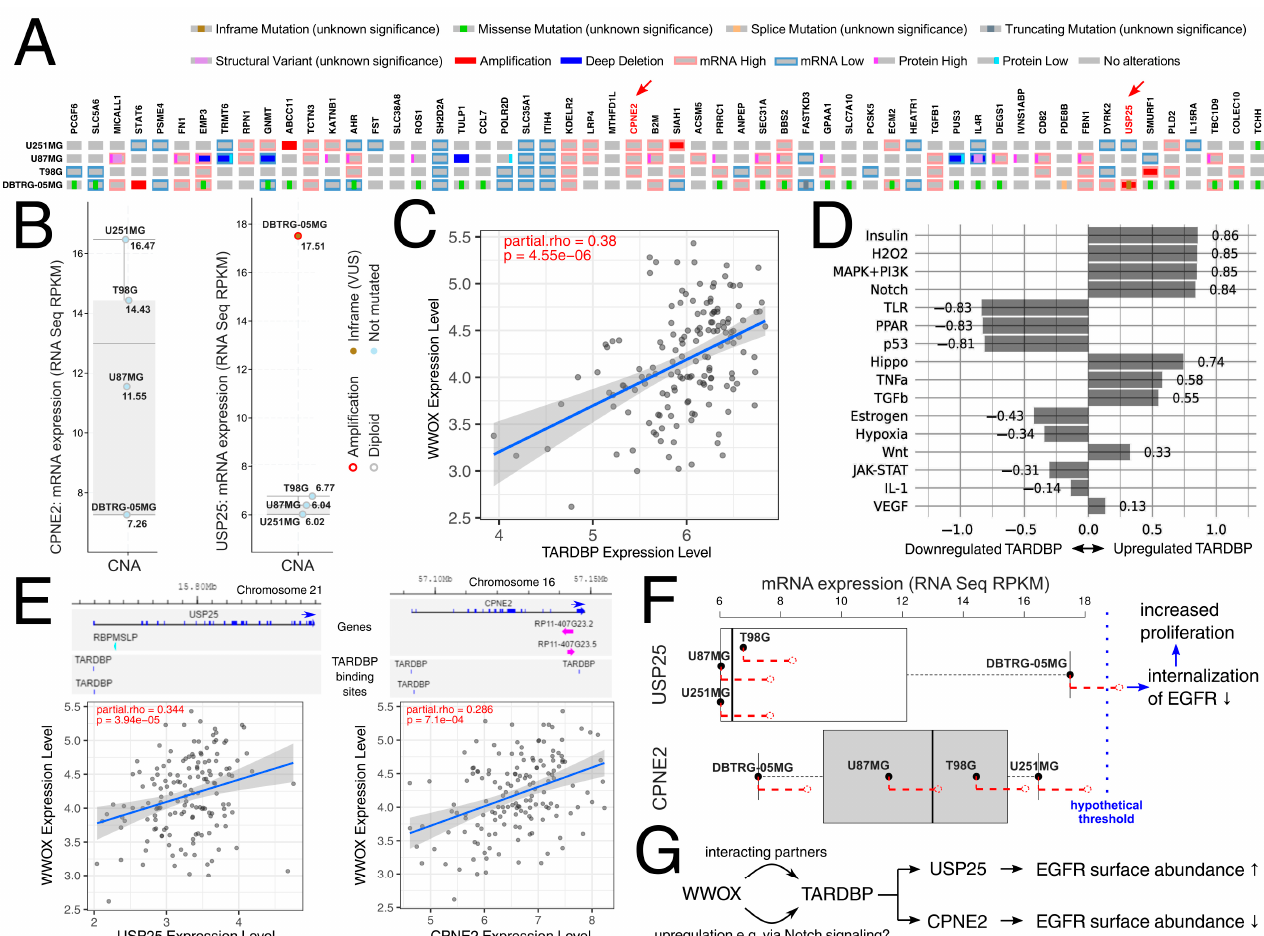
Figure 6. The possible explanation of discrepancies between DBTRG-05MG and other investigated cell lines. ( A ) Genomic profile of WWOX-related genes that are acquired from the full list of mutated genes in the DBTRG-05MG cell line. Interesting observations for CPNE2 and USP25 are marked with a red arrow. ( B ) Expression and copy number alterations of CPNE2 and USP25 . ( C ) Correlation between WWOX and TARDBP . ( D ) Signaling pathway enrichment for TARDBP . ( E ) Correlation between WWOX and USP25 or CPNE2 , with available TARDBP binding sites for the last two genes. ( F ) Di ff erences in the level of USP25 and CPNE2 . Following WWOX overexpression (marked with red), the expression of USP25 in the DBTRG-05MG cell line may be the fi rst to pass through the hypothetical threshold, leading to decreased EGFR internalization and a subsequent increase in proliferation. ( G ) A short synopsis of the described explanation. CNA—Copy number alteration. VUS—Variant of unknown signi fi cance.